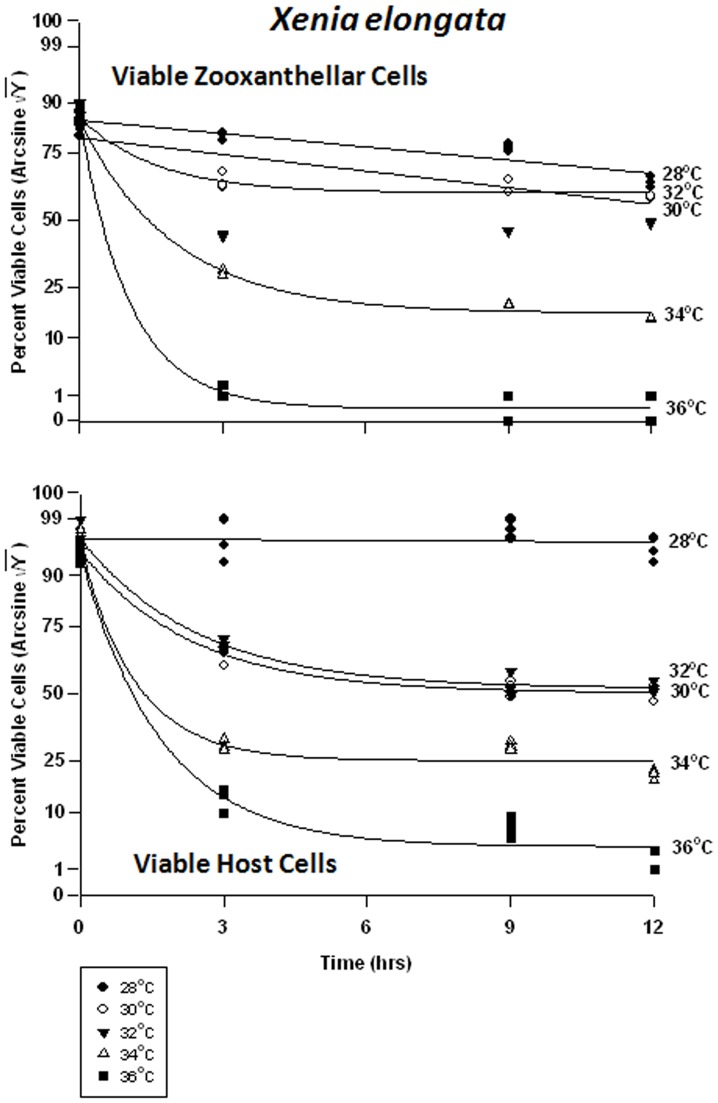
Effects of seawater temperature on percent viable endosymbiotic Symbiodinium and host coral Xenia elongata cells.In-hospite, collected over a12 h period. Corals exposed to 28 to 36°C treatments. • = 28°C; ○ = 30°C;▾ = 32°C; Δ = 34°C; ▪ = 36°C. Data transformed by arcsine for normalization purposes. Zooxanthellae: No significant linear regression at 28–30°C (p>0.05); i.e., regression coefficient not significantly different from “0″. Significant non-linear responses at 32–36°C (p<0.001; Y = 24.315+43.420*(1-e[−0.507X]); Y = 2.859+65.500*(1−e[−0.959X]); and Y = 45.335+31.910*(1−e[−0.434X]), respectively). Host Cells: No significant linear regression at 28°C (p>0.05); i.e., linear regression coefficient not significantly different than “0″. Significant non-linear responses at 30, 32, 34, and 36°C (p<0.001; Y = 46.369+33.664*(1−e[−0.411X]); Y = 30.191+48.525*(1−e[−0.879X]); Y = 10.899+65.806*(1−e[−0.597X]), and Y = 51.409+16.910*(1−e[−0.625X]), respectively).